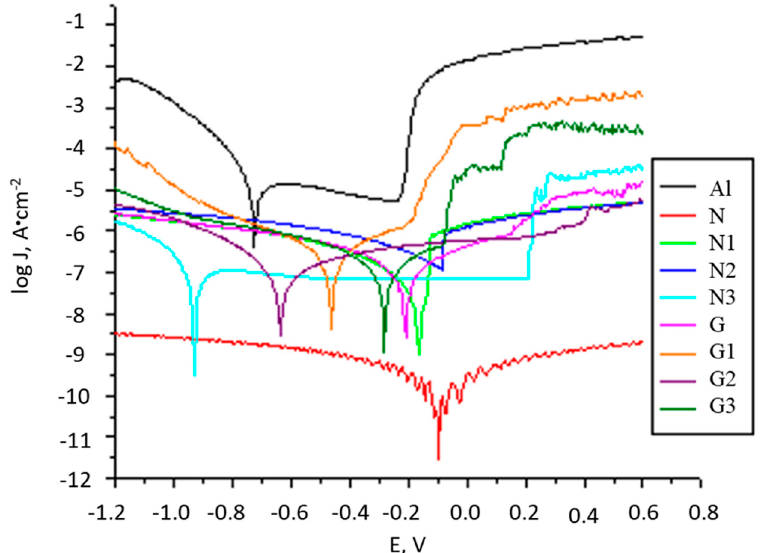
Figure 2. The log J versus E, for all prepared electrodes (Al, N, N1, N2, N3, G, G1, G2, and G3) immersed in 3% NaCl solution.